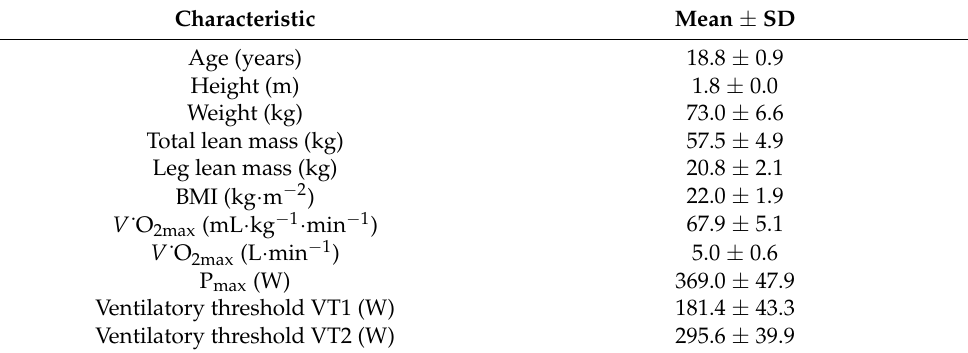
Table 1. Participants’ characteristics ( n =